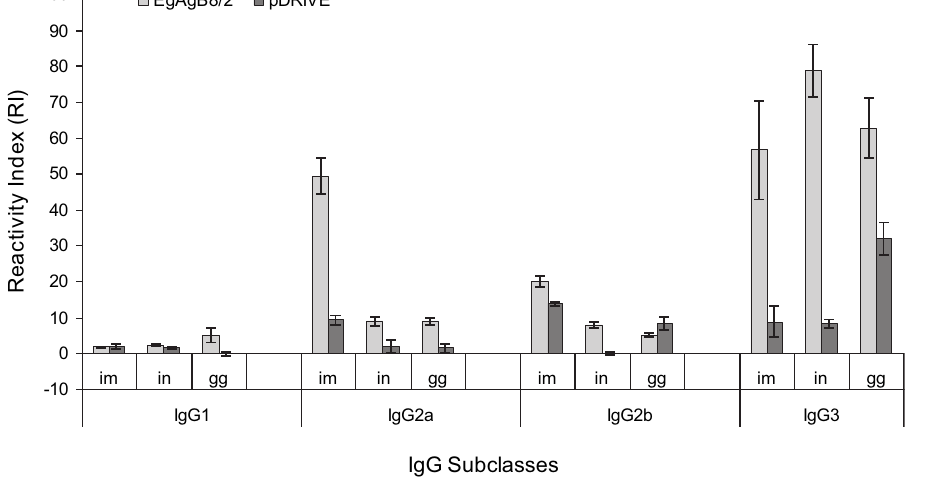
Fig 1. – Serum IgG isotype titers (mean ± SD) of mice, obtained 50 days after the first immunization with recombi- nant EgAgB8/2 plasmid and control or empty plasmid (pDRIVE), using different routes of immunization (i.m., i.n. and g.g.). Specific IgG1, IgG2a, IgG2b and IgG3 titers were deter- mined by ELISA assay against purified AgB. Data are repre- sented in mean value of reac- tivity index (R.I.) and stan- dard errors of